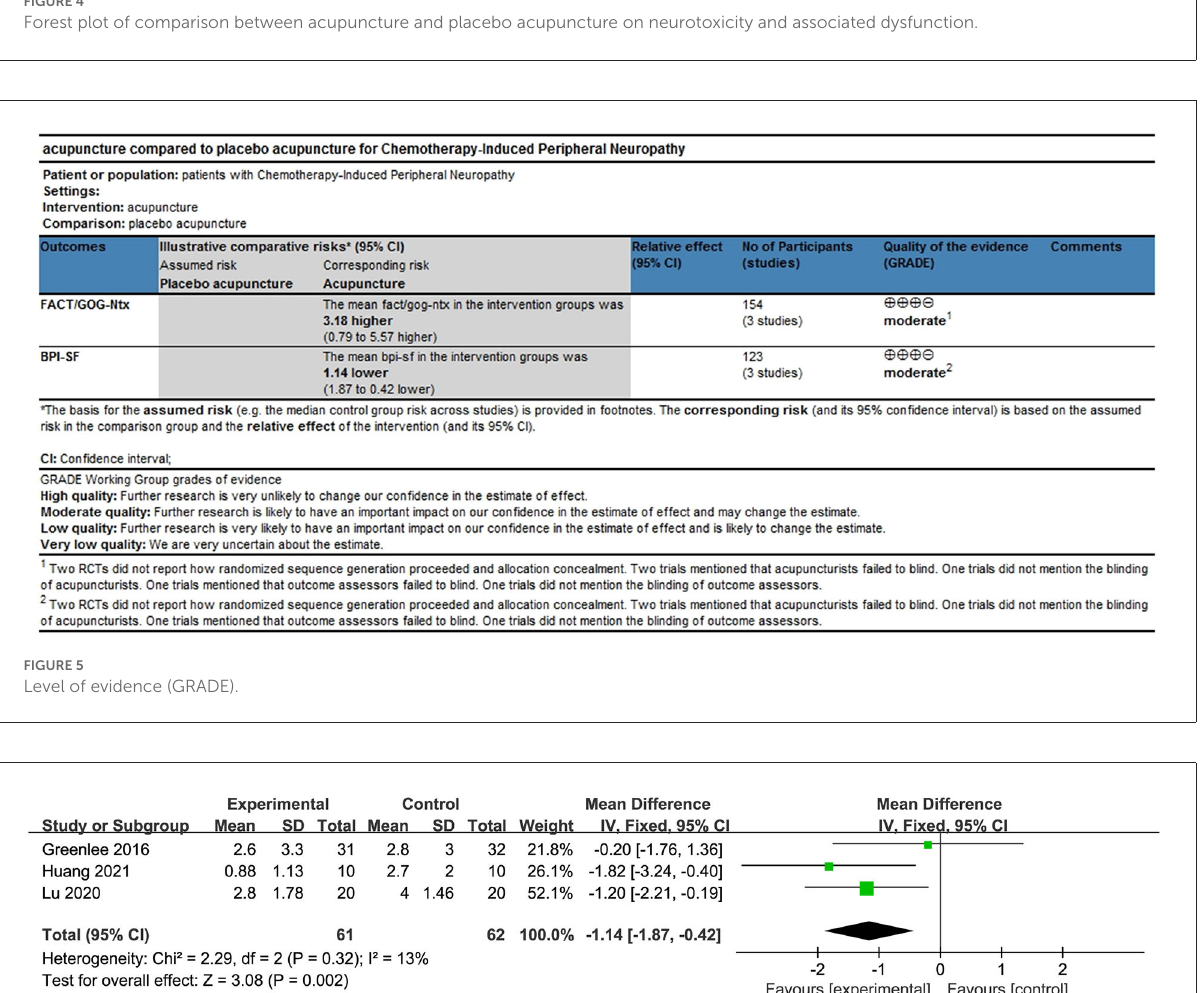
FIGURE6 Forest plot of comparison between acupuncture and placebo acupuncture on neuropathic pain.